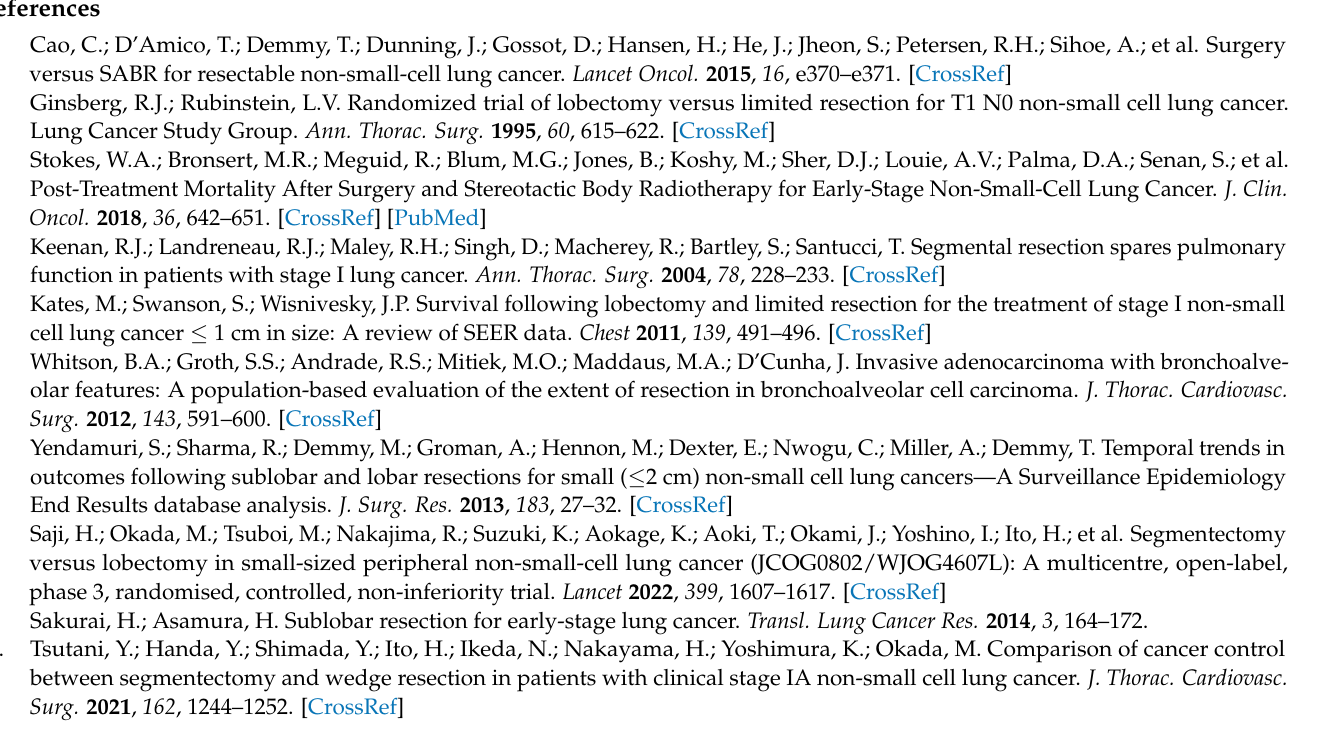
Figure S3: Subgroup analysis of overall survival after PSM following segmentectomy or wedge resection in NSCLC patients with tumors ≤ 2 cm according to histological type: LUSC, LUAD, and OC. LUSC, Lung squamous cell carcinoma; LUAD, Lung adenocarcinoma; OC, Other carcinoma; Figure S4: Subgroup analysis of overall survival after PSM following segmentectomy or wedge resection in NSCLC patients with tumors ≤ 2 cm, according to sex: male and female; Table S1: Details of Cox Regression